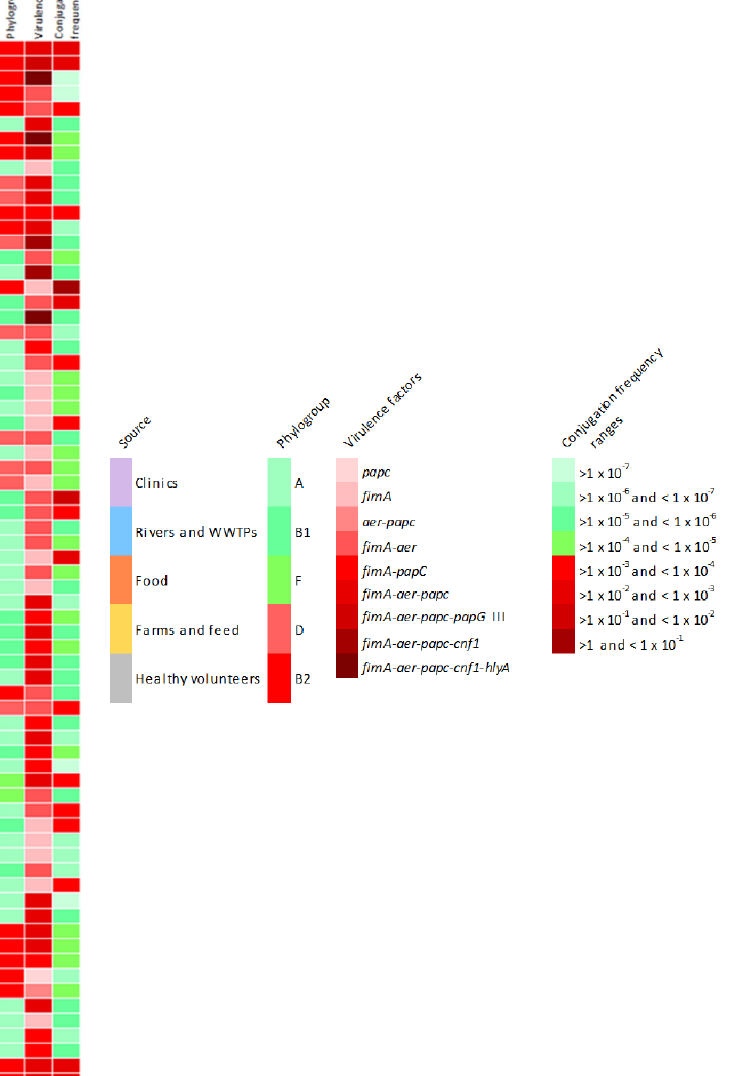
Figure 4. PCRs for the ESBL genes detection in transconjugants. ( A ) Presence of TEM-1 gene. 1: 1F; 2: